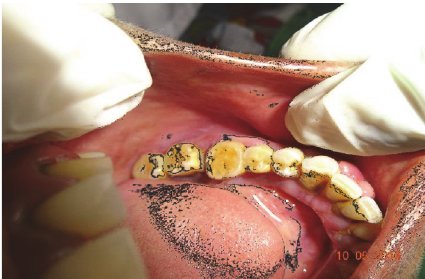
Figure 2: Intraoral swelling with no obliteration of sulcus.